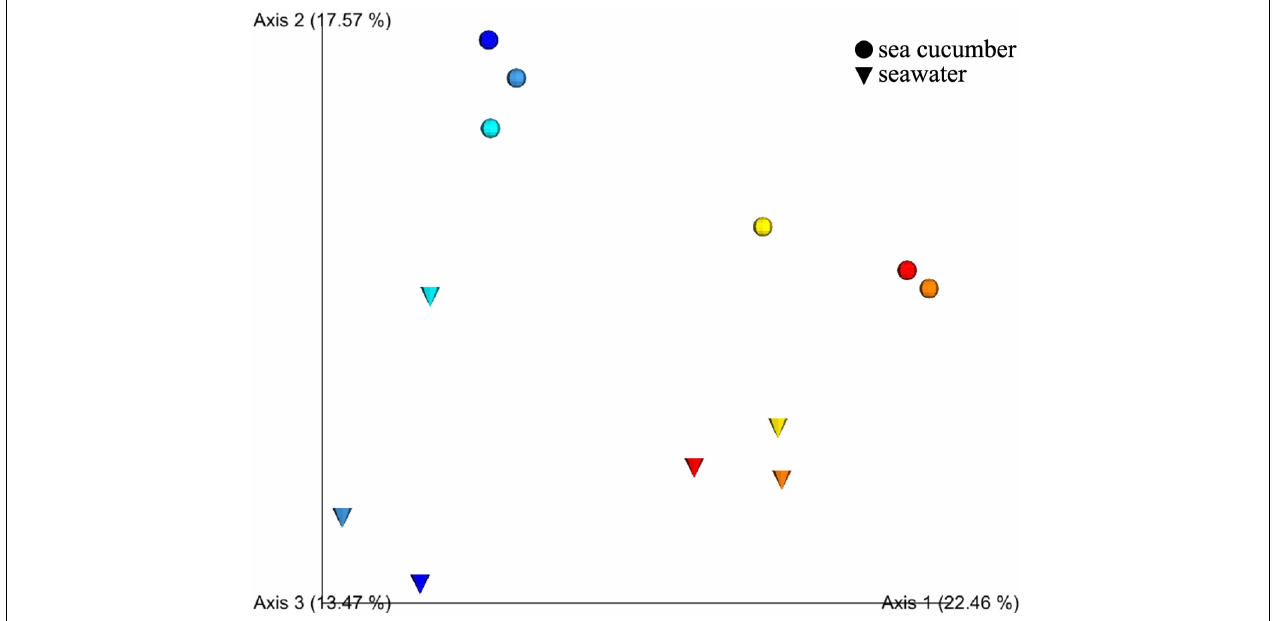
FIGURE 1 | Prinicipal coordinate analysis (PCoA) plot based on unweighted UniFrac distances obtained by comparison of microbiotas at each developmental stage of sea cucumber larva. Blue, fertilized egg; light blue, gastrula; cyan, early auricularia; yellow, late auricularia group; orange, pentactula group; red, juvenile. Circle and cone indicated microbiota from sea cucumber and rearing seawater,